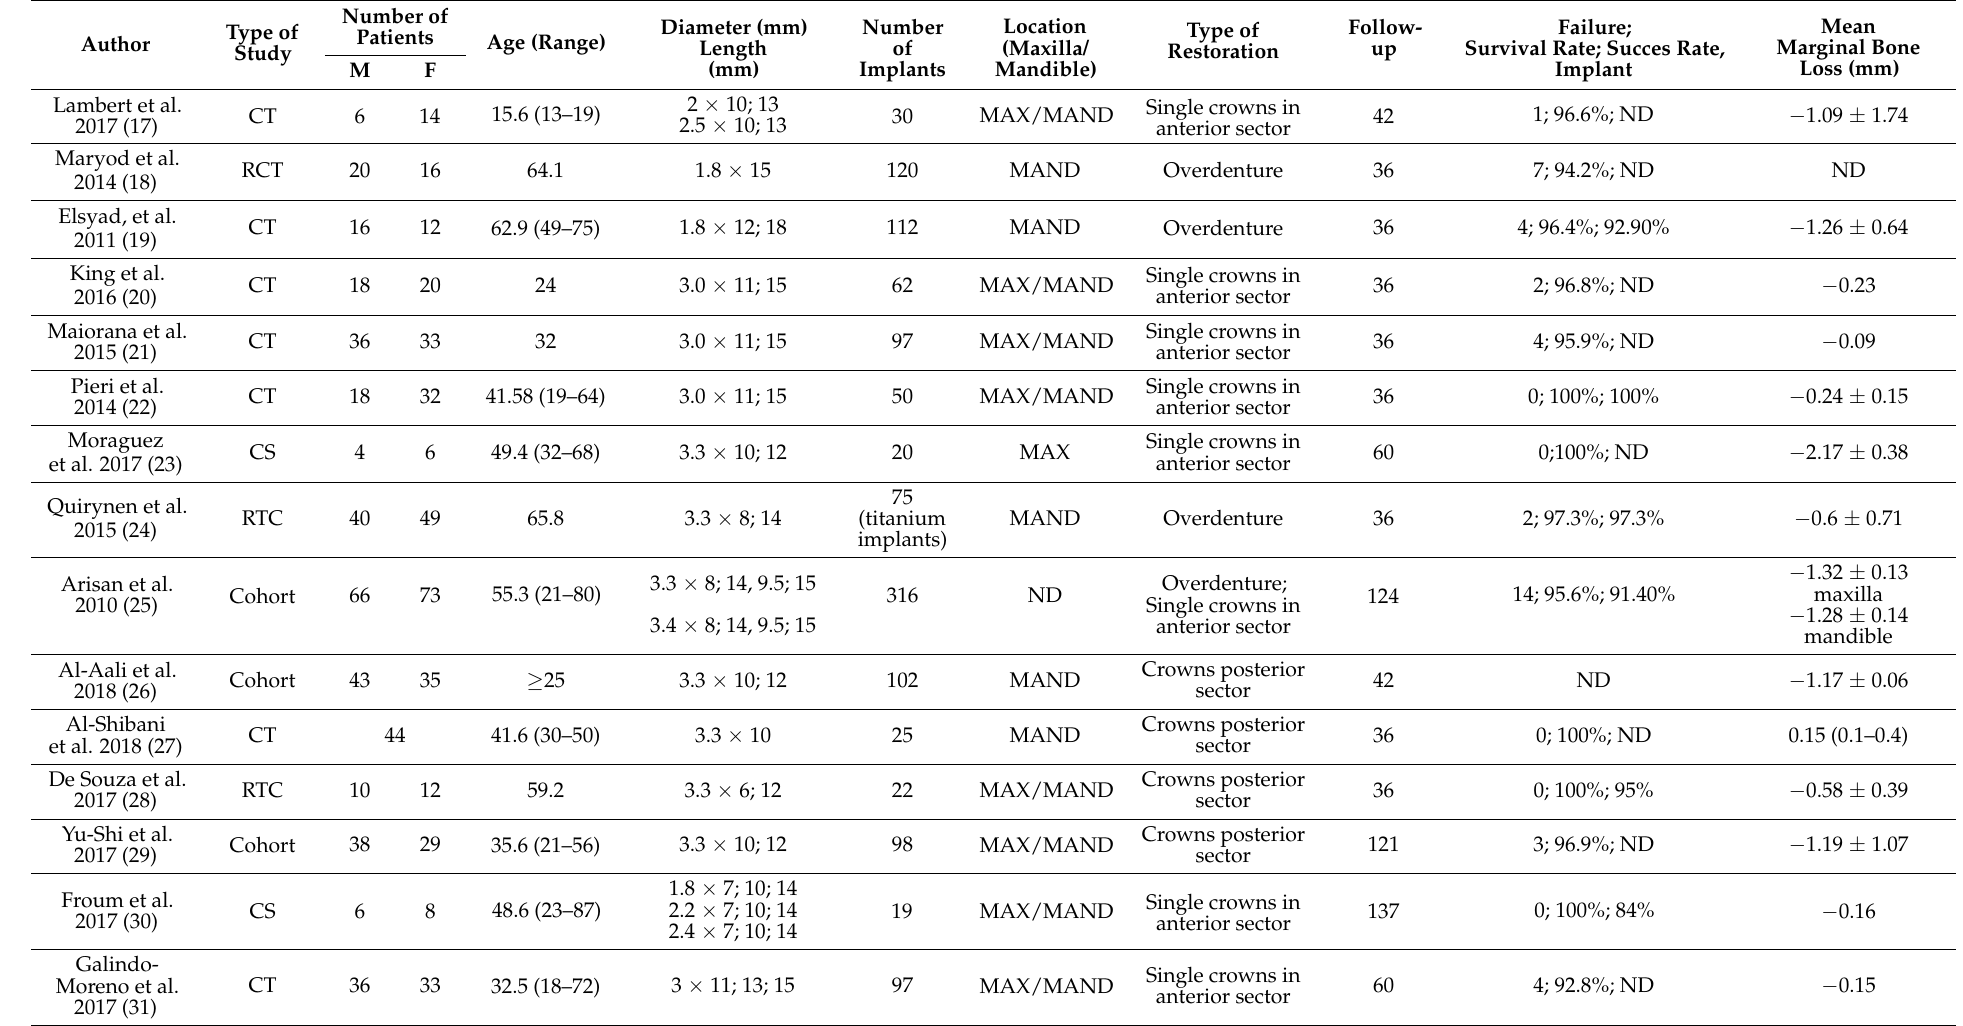
Table 1. Characteristics of the articles included. M: Males; F: Females; MAX: Maxilla; MAND: Mandible; RCT: Randomized Clinical Trial; CT: Clinical Trial; CS: Case Series; ND: No